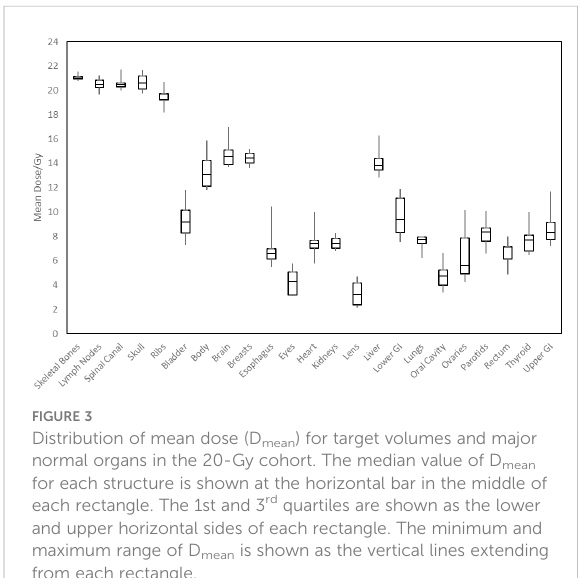
FIGURE 4 Distribution of mean dose (D mean ) for target volumes and major normal organs in the historical 12-Gy TMLI treatment plans. The median value of D mean for each structure is shown at the horizontal bar in the middle of each rectangle. The 1st and 3rd quartiles are shown as the lower and upper horizontal sides of each rectangle. The minimum and maximum range of D mean is shown as the vertical lines extending from each rectangle. The red dots are D mean data in the three VMAT TMLI treatment plans in the 12-Gy